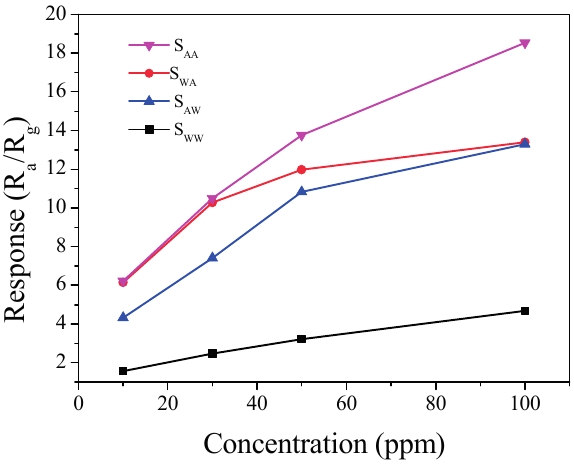
Figure 5. Response of sensors at 250 °C versus acetone